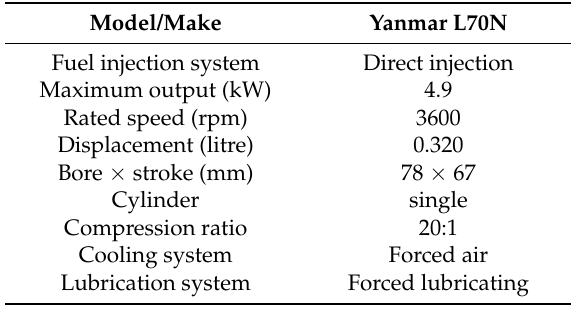
Table 1. Engine specifications.